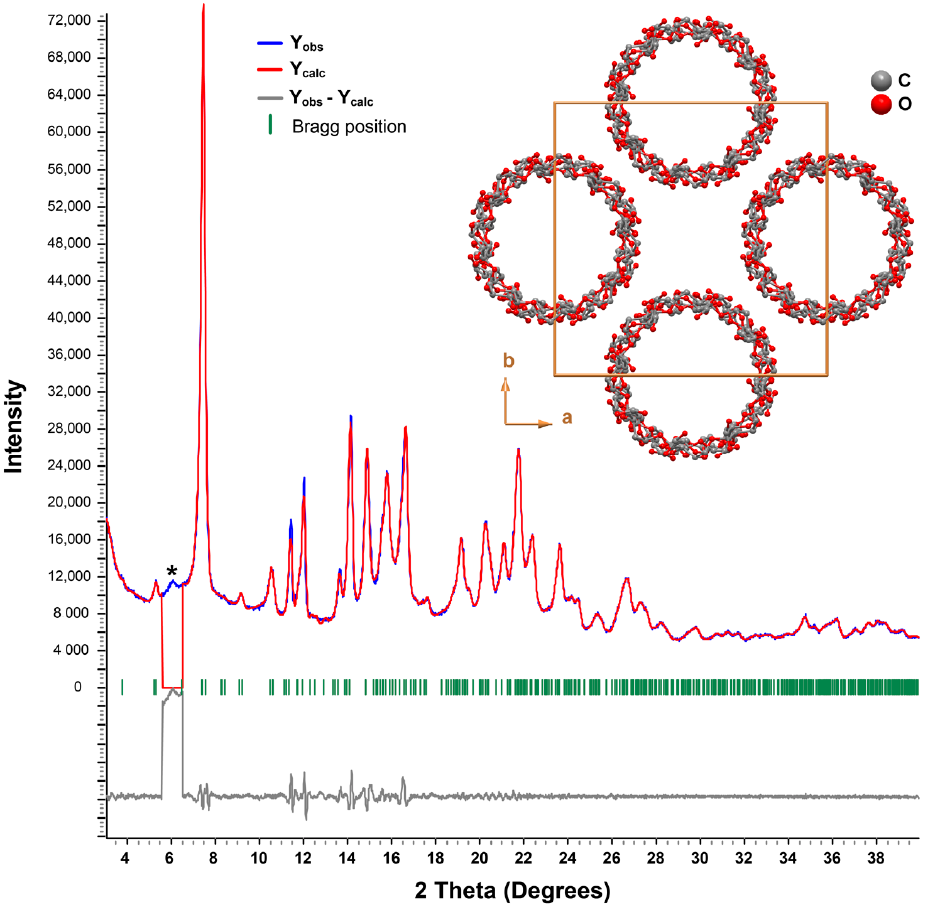
Figure 3. Final Pawley plot of γ -CD · gingerols. Observed data points are indicated as a blue line, the best fit profile (upper trace) and the difference pattern (lower trace) are drawn as solid red and grey lines, respectively. Green vertical bars indicate the angular positions of the allowed Bragg reflections. The inset depicts a perspective view along the [001] direction of the close packing of γ -CD in crystal structures pertaining inclusion compounds. The asterisk depicts the presence of a small amount of an unidentified crystalline phase.